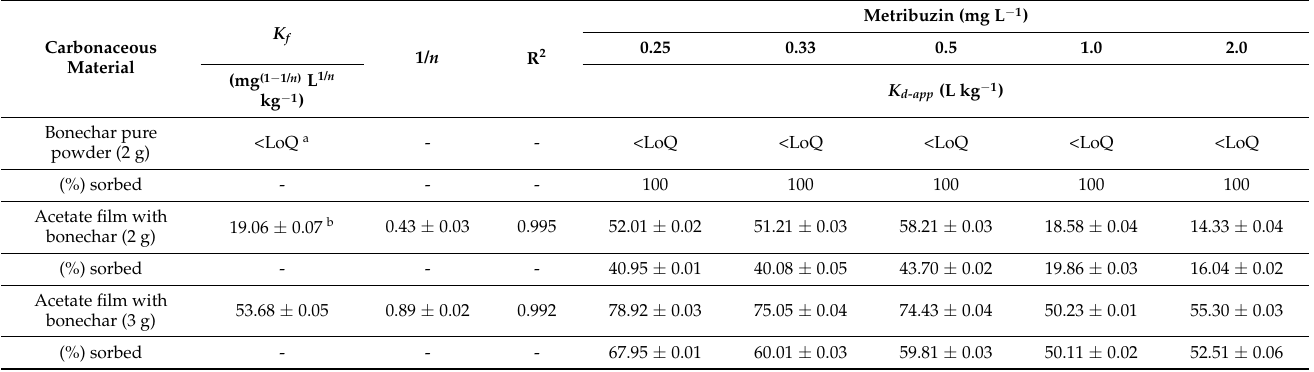
Table 3. Freundlich model isotherm sorption parameters and sorption coefficients ( K d ‐ app ) of